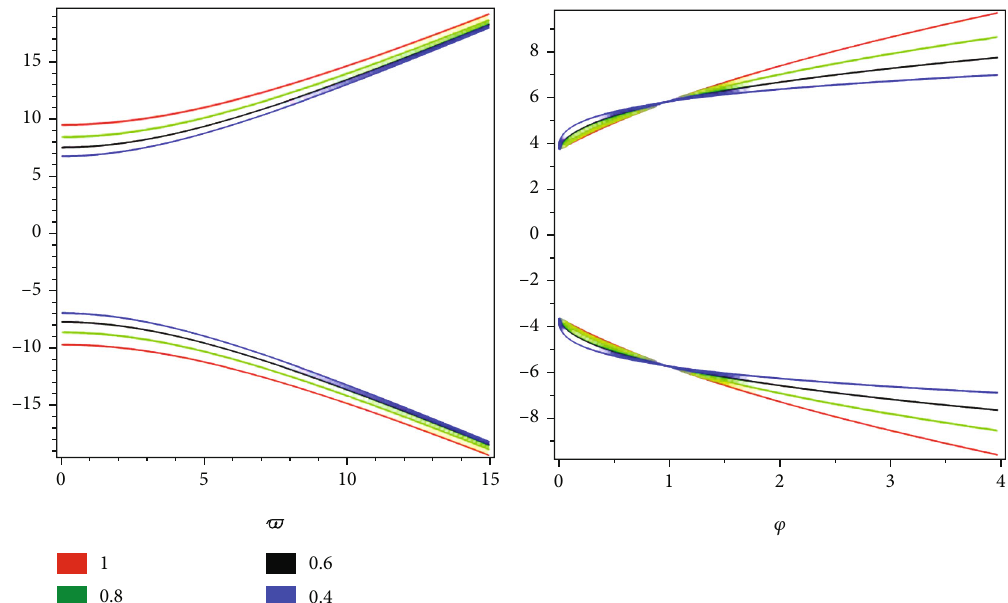
We have given simulation of problem 1 at di ff erent noninte- ger order ð 0 < ρ ≤ 1 Þ for lower and upper portions of fuzzy solutions given in Figure 1 in two-dimensional form, respec- tively. The two similar color legends show the lower and upper branches of fuzzy solutions,